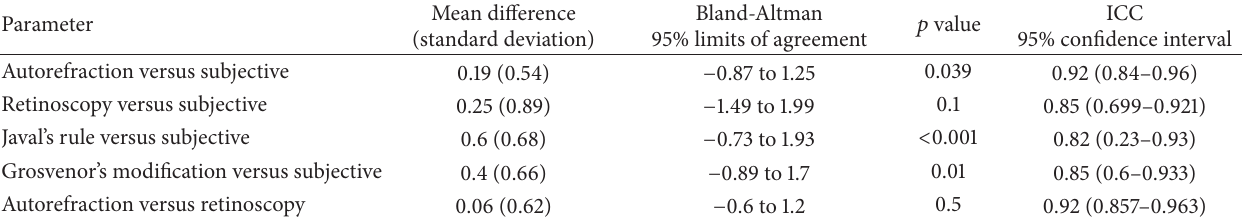
Table 3: The Bland-Altman 95% limits agreement and intraclass correlation coefficient for total astigmatism.